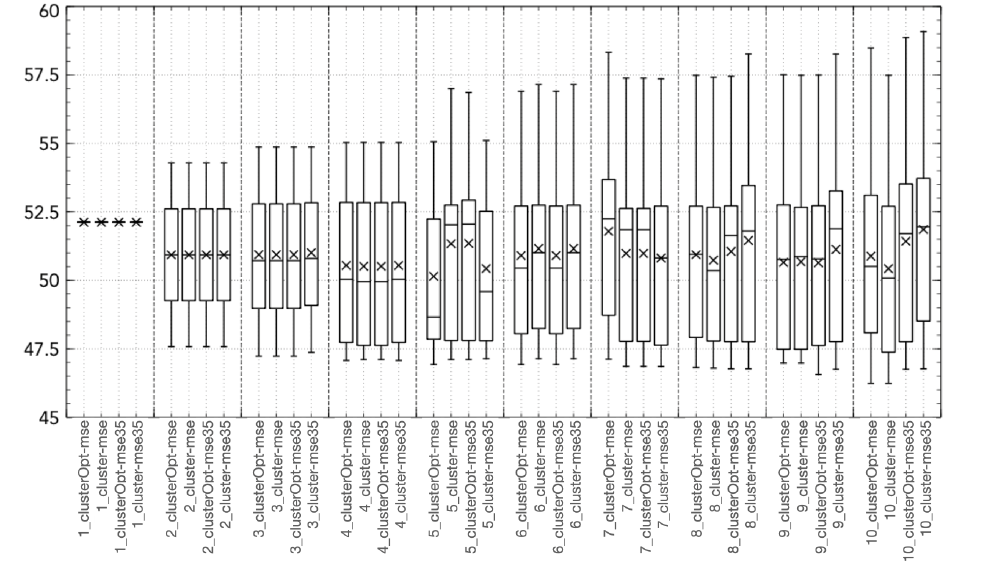
Figure 4. Boxplot of coordinate 2 ( u 1 ( t ) , NO x emissions at time t ) of the centroid [kg/d/m 2